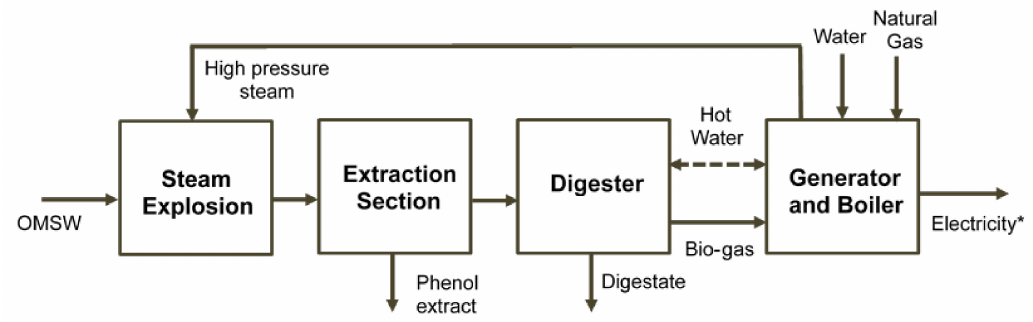
Figure 1. Bio-refinery scheme consisting of steam explosion solubilization, phenol recovery, anaerobic digestion and a cogeneration system. * Net electricity production after subtracting the total electricity consumed from the electricity produced.